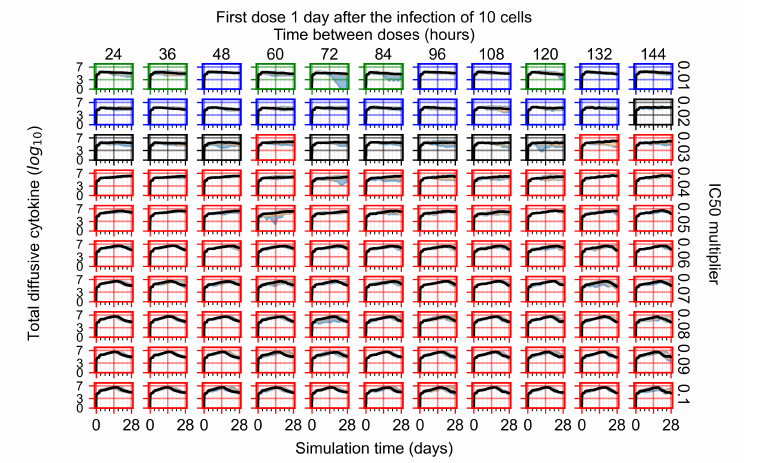
Figure A121. Diffusive cytokine amount for eight replicas of the treatment simulation, Y axis in log scale, and exponent values as tick